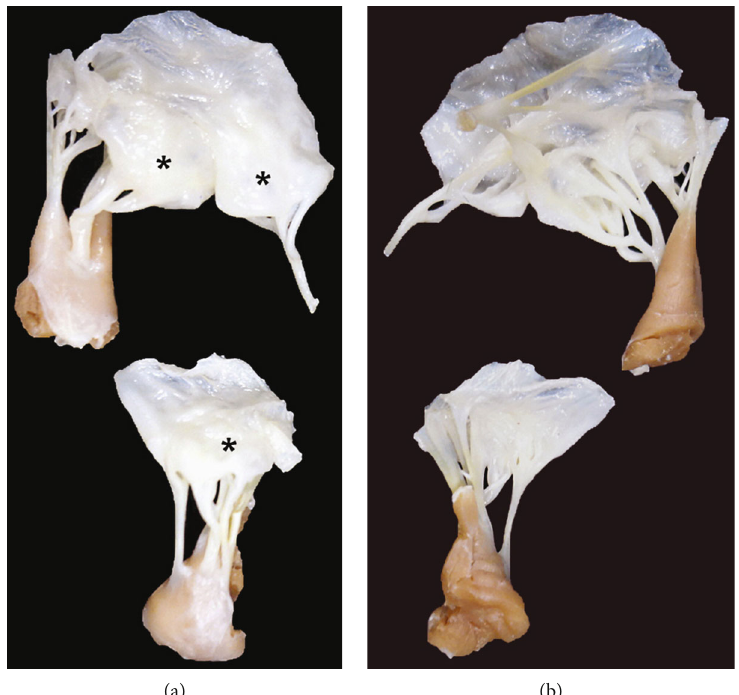
Figure 1: Surgical specimen from tricuspid valve repair. (a) Atrial aspect: cusps are glistening and dome-shaped ( ∗ ). (b) Ventricular aspect: chordae are irregularly thickened and branched.